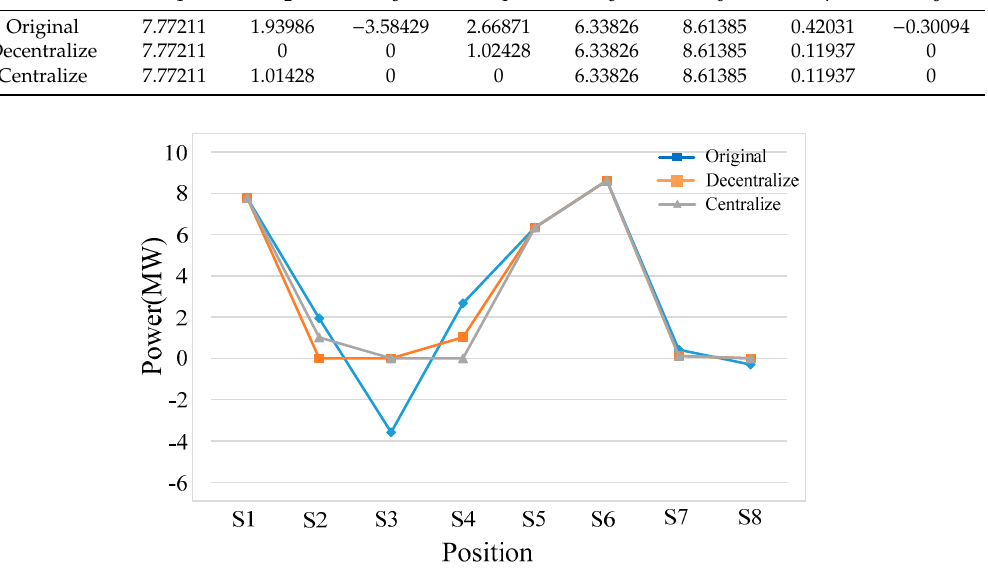
Table 3. Feeder power before and after regulation under case 1 (MW).